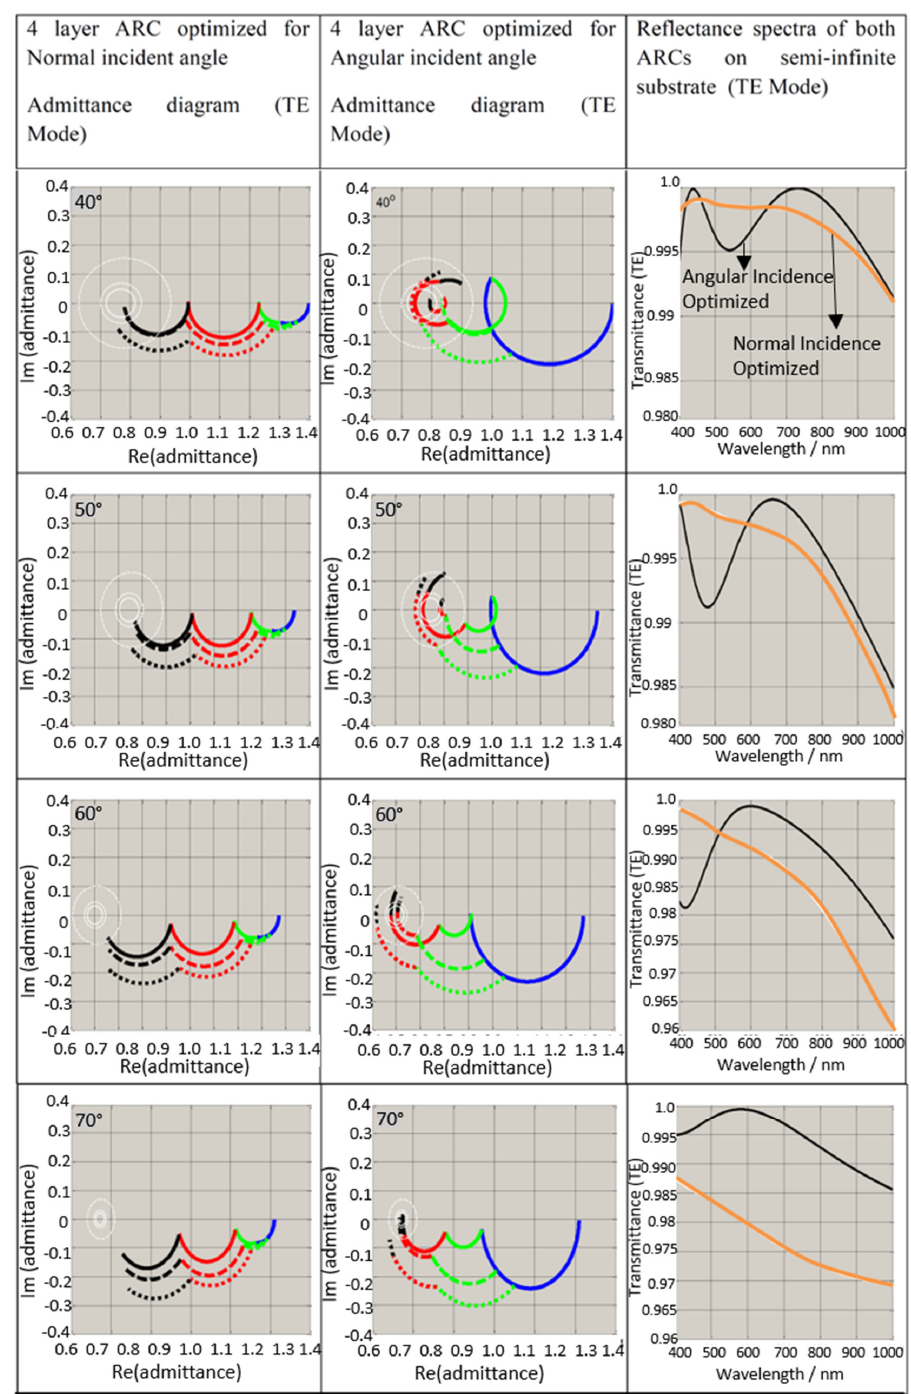
Figure 4. Admittance loci for the normal incidence optimized and angular incidence optimized ARC designs for TE mode. The TE transmittance spectra for these designs on a semi ‐ infinite glass substrate are also shown. The black and orange lines represent angular and normal incidence optimized designs respectively. The admittance loci representations are shown for increasing angles of incidences from 0° to 70°.